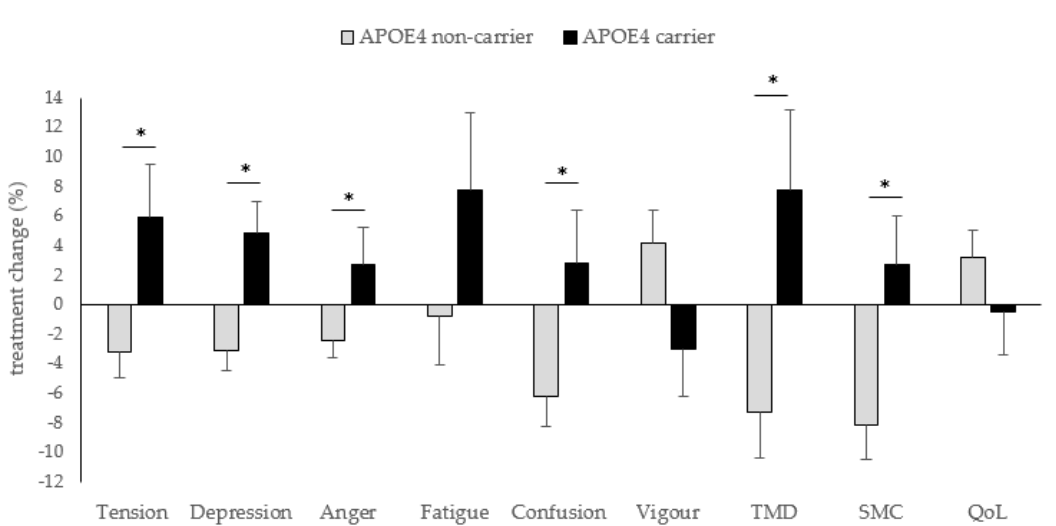
Figure 1. Differences between APOE4 carriers ( n = 16) and APOE4 non-carriers ( n = 44) in treatment changes of mental wellbeing measures and quality of life following fish oil supplementation. * Significant, p < 0.05. TMD: total mood disturbance, SMC: subjective memory complaints, QoL: quality of life.